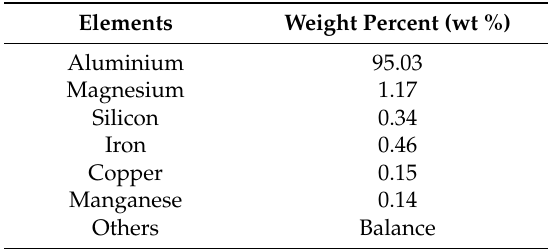
Table 1. Average chemical element of as-received AA6061-T6